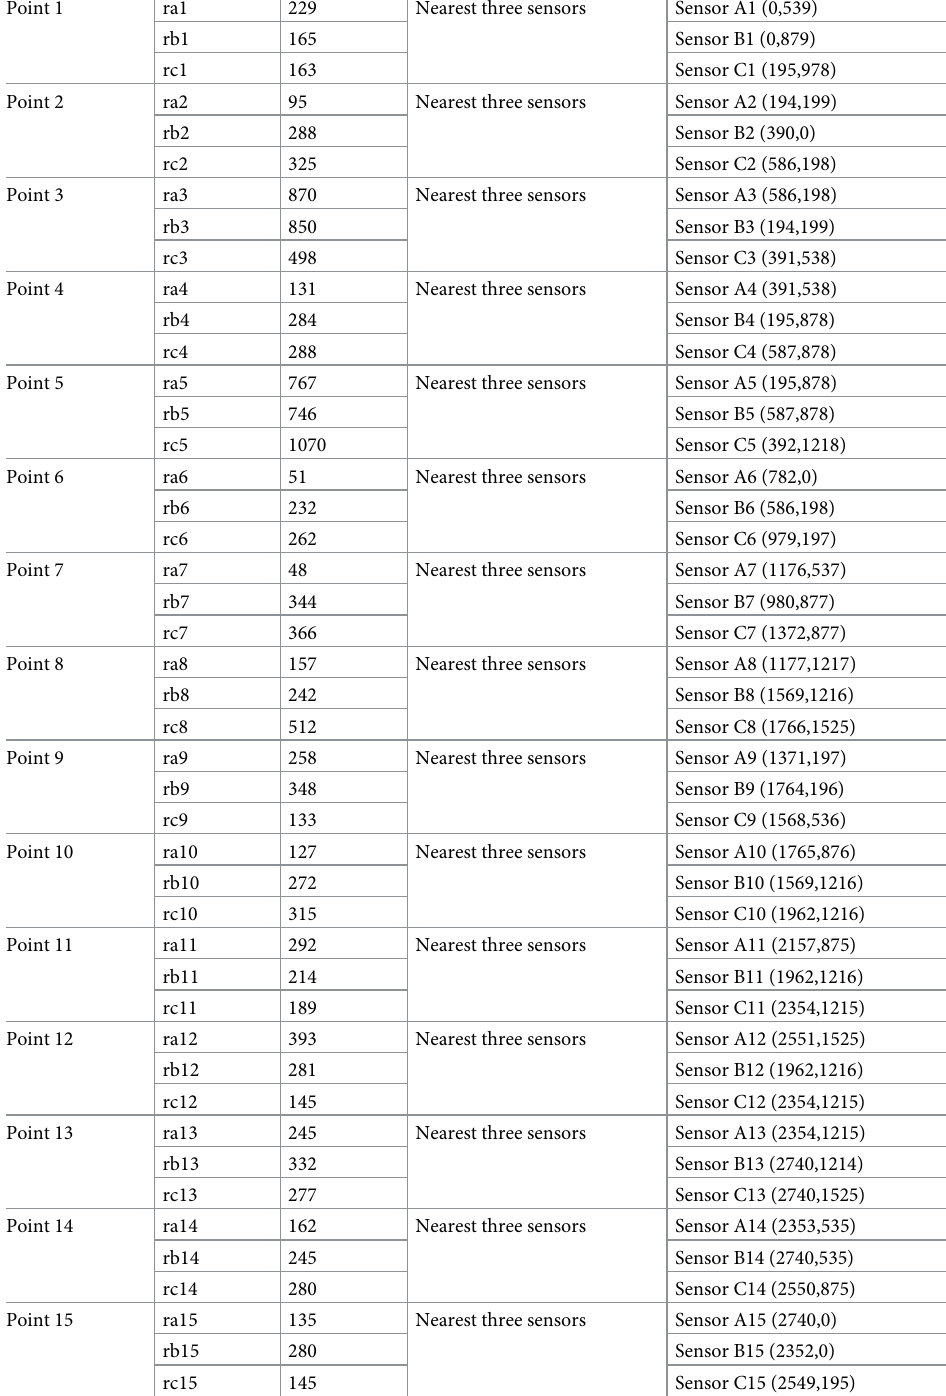
Table 4. Parameters applied in equation set-up